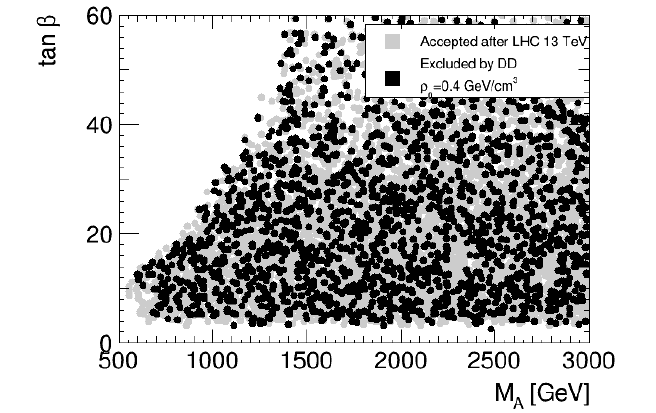
Figure 18 . pMSSM points in the ( M A ; tan (cid:12) ) parameter plane. The accepted model points which are in agreement with the LHC 8 and 13 TeV data from Higgs and direct searches are shown in gray. The black points are excluded by direct